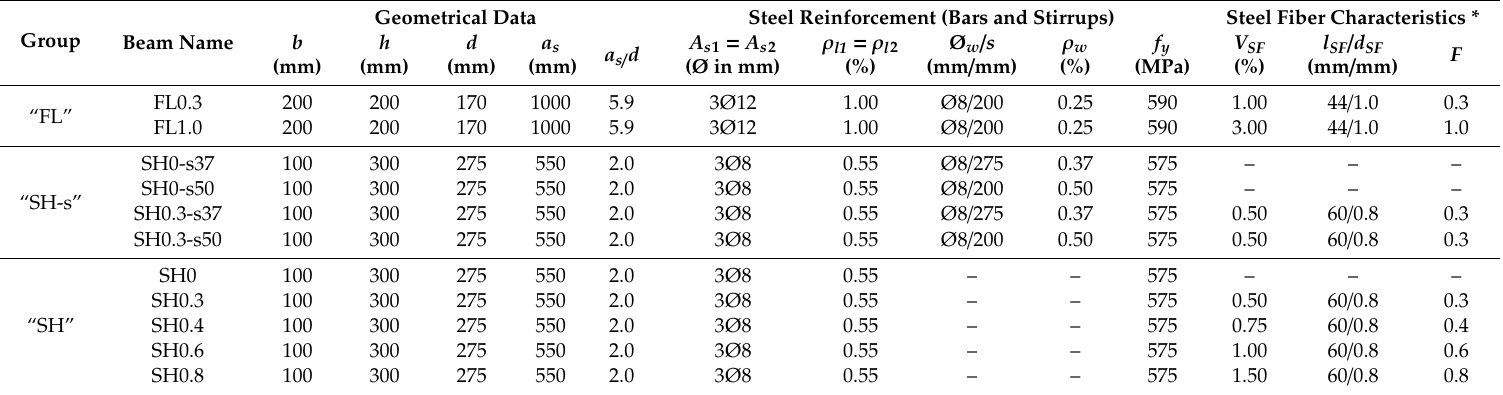
Table 1. Properties of the tested